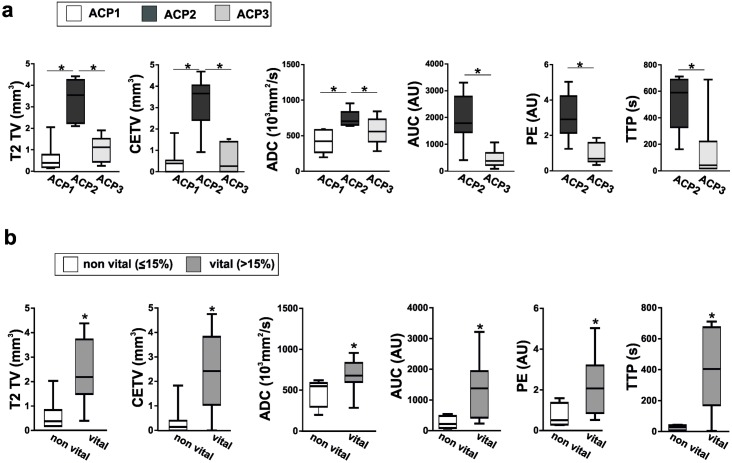
MRI data correlated with patient specific grafts and vitality.a: Patient derived engrafted tumors were analyzed in terms of T2 tumor volume (T2 TV), contrast-enhancing tumor volume (CETV), apparent diffusion coefficient (ADC), area-under-the-curve (AUC), peak enhancement (PE) and time-to-peak (TTP). b: Corresponding data were also evaluated in matters of vitality with a cutoff of 15% discriminating non-vital from vital engrafted tumors. Significant differences are marked by an asterisk (*). Detailed results e.g. mean values and p-values are listed in S2 Table.